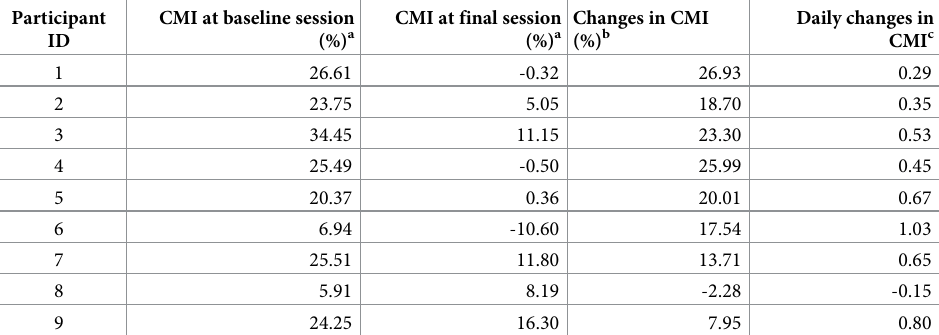
Table 2. CMI of walking velocity in each